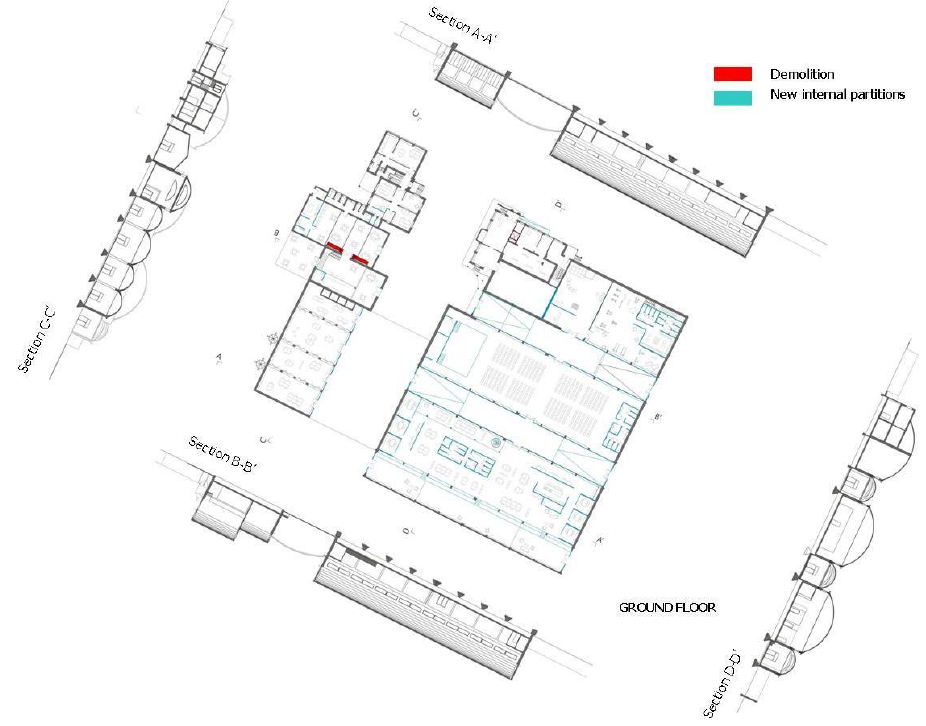
Figure 7. Plan and sections: adaptive reuse proposal (in green lightweight modular partition walls).